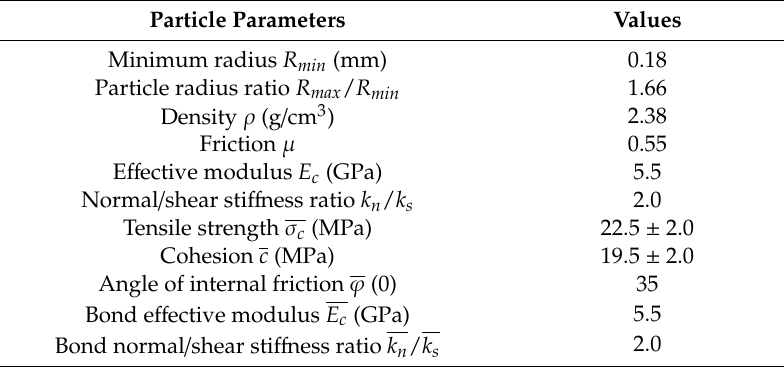
Table 3. Microscopic parameters used in the numerical